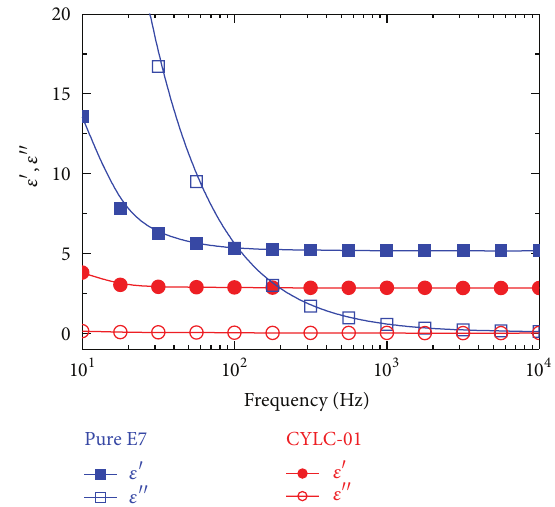
Figure 1: The dielectric spectra of the low-resistivity NLC E7 and high-resistivity NLC CYLC-01 confined in homogeneous cells at 303 K. 𝜀 󸀠 and 𝜀 󸀠󸀠 are the real and imaginary parts of the complex dielectric